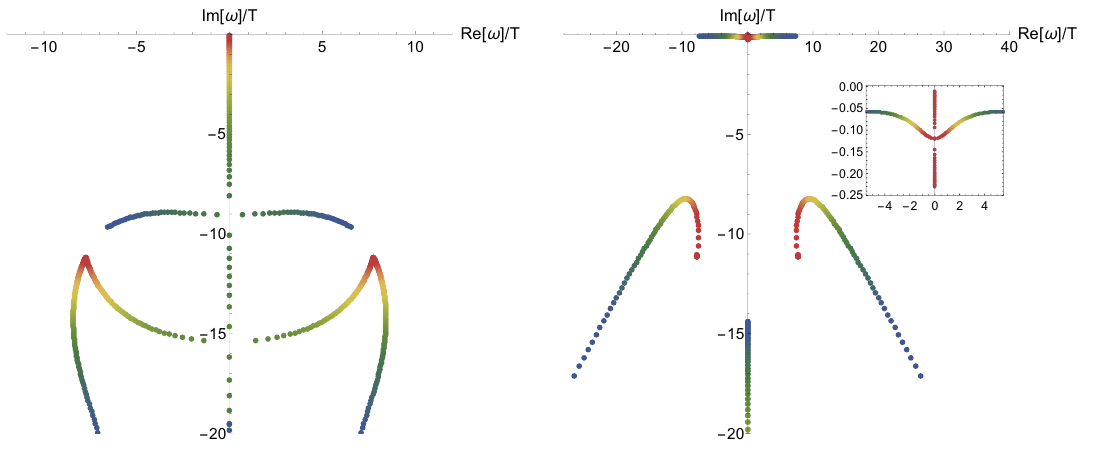
Figure 2 . The real and imaginary parts of the lowest quasi-normal modes at k = 0. Left: (cid:12) = 0 and T=m 2 [0 : 10 ; 1 : 07] (blue-red). Right: (cid:12) = 60 and T=m 2 [0 : 16 ; 68 : 97] (blue-red). is small compared to that of the next lowest mode. By decreasing T=m below a critical value the two lowest purely imaginary modes collide developing a non-zero real part in the (cid:12) = 0.